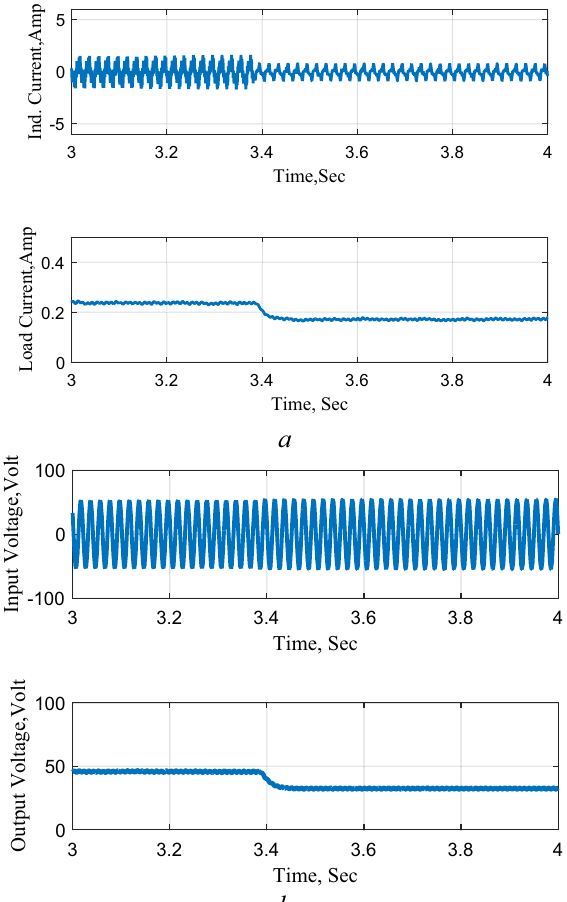
Figure 20. Response to a step change in the reference voltage AC–DC. ( a ) Inductor and output currents, ( b ) input and output voltages.